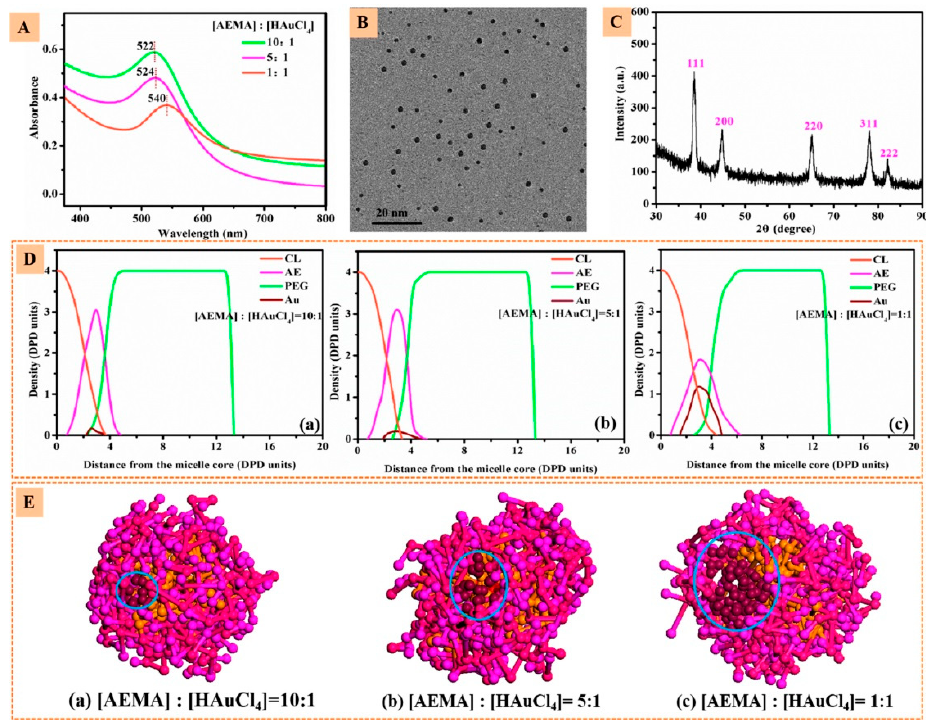
Figure 7. ( A ) UV − vis absorption spectra of β -CD-(PCL-PAEMA-PPEGMA)21/AuNPs at different (AEMA):(HAuCl 4 ) molar ratios. ( B ) Transmission Electron Microscopy (TEM) image and ( C ) XRD plot of β -CD-(PCL-PAEMA-PPEGMA)21/AuNPs at (AEMA):(HAuCl 4 ) molar ratio of 5. ( D ) Density profiles of different beads and ( E ) cross-section views of β -CD-(PCL-PAEMA-PPEGMA)21/AuNPs at different (AEMA):(HAuCl 4 ) molar ratios. Reprinted with permission from [139]. Copyright American Chemical Society, 2017.